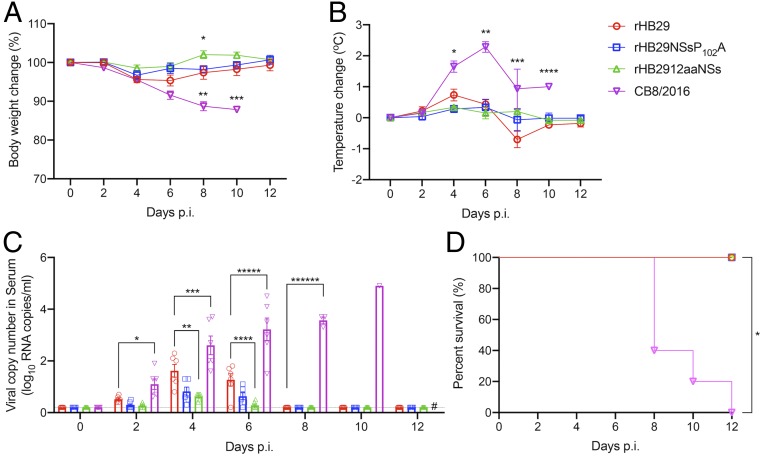
Relative body weight, temperature change, serum viral RNA copy number, and survival of aged ferrets infected with recombinant SFTS viruses. (A–D) Twelve ferrets in each group were inoculated with 4 × 106 PFUs of rHB29 (red), 4 × 106 PFUs of rHB29NSsP102A (blue), 5 × 105 PFUs of rHB2912aaNSs (green), or 5 × 105 PFUs of CB8/2016 (purple). Relative weight (A), temperature (B), viral RNA copy number in the serum (C), and survival (D) were assessed at the indicated times p.i., and mean values are shown ± SEM. The asterisks indicate significance compared to each day p.i. sample analyzed by one-way ANOVA with Dunnett multiple comparison test (A–C) or the 2-tailed Mantel–Cox method (D). *P = 0.0424, **P = 0.0023 and ***P < 0.0134 (A); *P = 0.0007, **P < 0.0001, ***P = 0.0113 and ****P = 0.0032 (B); *P = 0.0031, **P = 0.0192, ***P = 0.0214, ****P = 0.0378, *****P = 0.0001, and ******P < 0.0001, (C); and *P < 0.0001 (D). # Sample not tested as animals had died/been killed.